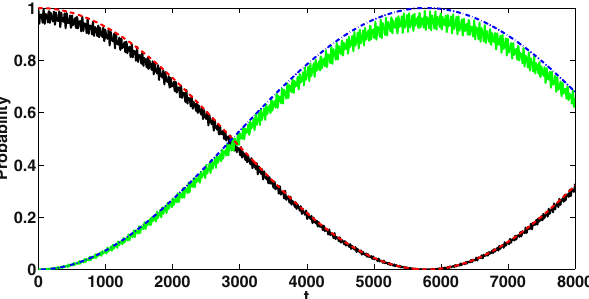
Figure 4. Probability of detecting the state |14 〉 from |50 〉 as a function of t . Detecting other states are practically zero. Continuous black(dashed) and continuous green (dashed-dot) line corresponds to P 50 and P 14 calculated numerically (approximate analytical solution ψ t ( ) ). We set Δ = − 0.2, χ = 0.1, J = 0.035. The system parameters are used in the unit of ω 1 .